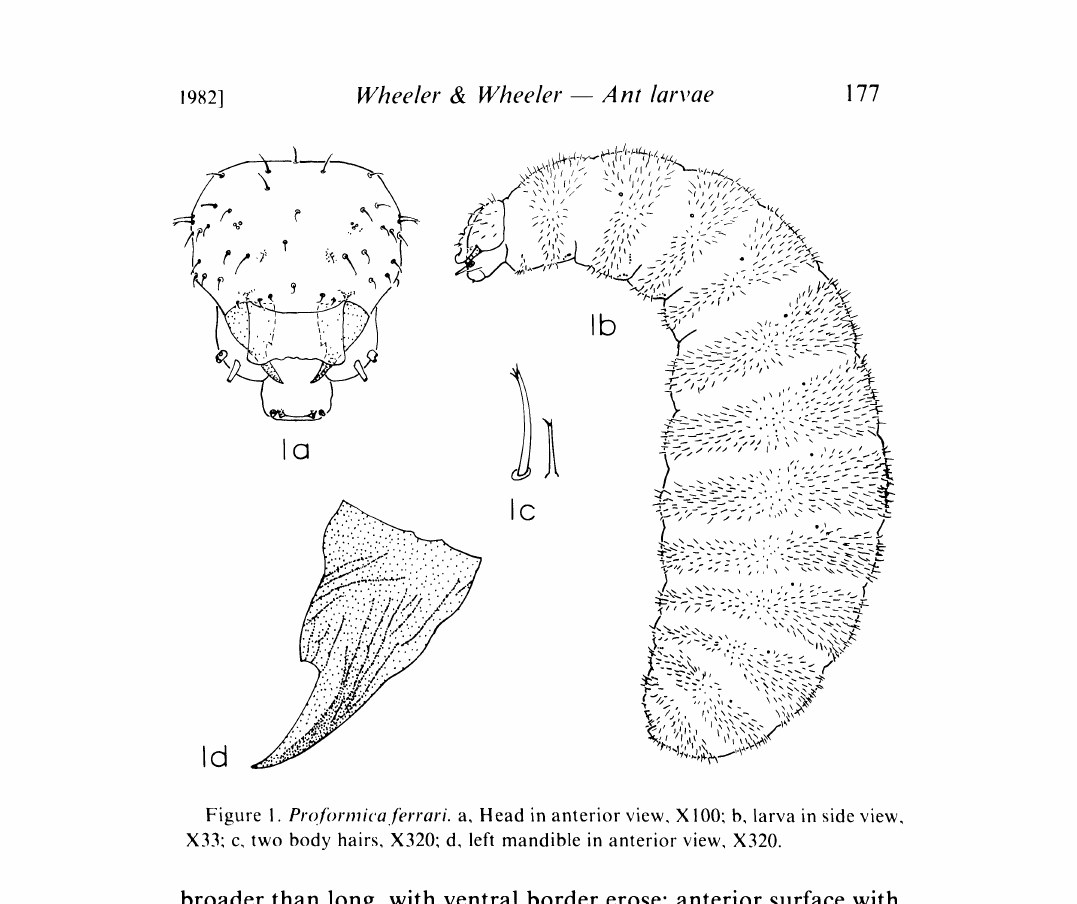
Figure I. Pro.lbrmica.f’errari. a, Head in anterior view, X 100; b, larva in side view, X33: c, two body hairs, X320; d, left mandible in anterior view, X320. broader than long, with ventral border erose; anterior surface with 12 sensilla; with minute papillae near ventral border; ventral surface papillose and with 6 sensilla; posterior surface densely spinulose, the spinules minute and arranged in rows which radiate from the dorsolateral angles, the rows continuous, near the base but broken distally; posterior surface with about 6 sensilla. Mandible large; ectatommoid (i.e., subtriangular; with a medial blade arising from the anterior surface and bearing a small medial tooth; apex curved medially to form a tooth); anterior and posterior surfaces with longitudinal rugae. Maxilla rather large; with paraboloidal apex; integument papillose, the papillae bearing minute spinules; palp a short rounded knob bearing 5 (! encapsulated and 4 bearing a spinule each) sensilla; galea digitiform with 2 apical sensilla. Labium prominent; integument papillose; with a dorsal transverse welt bearing minute spinules in transverse rows; palp a low knob with